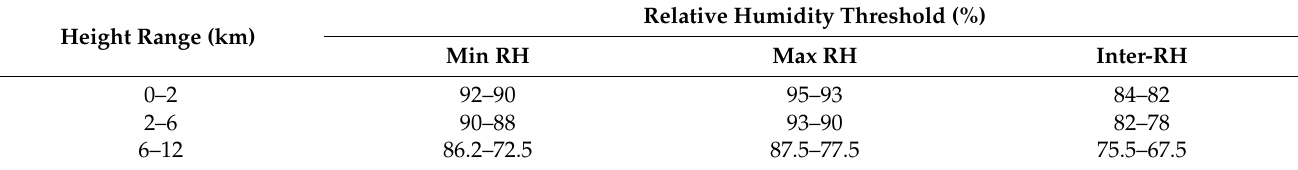
Table 2. Height-resolving RH